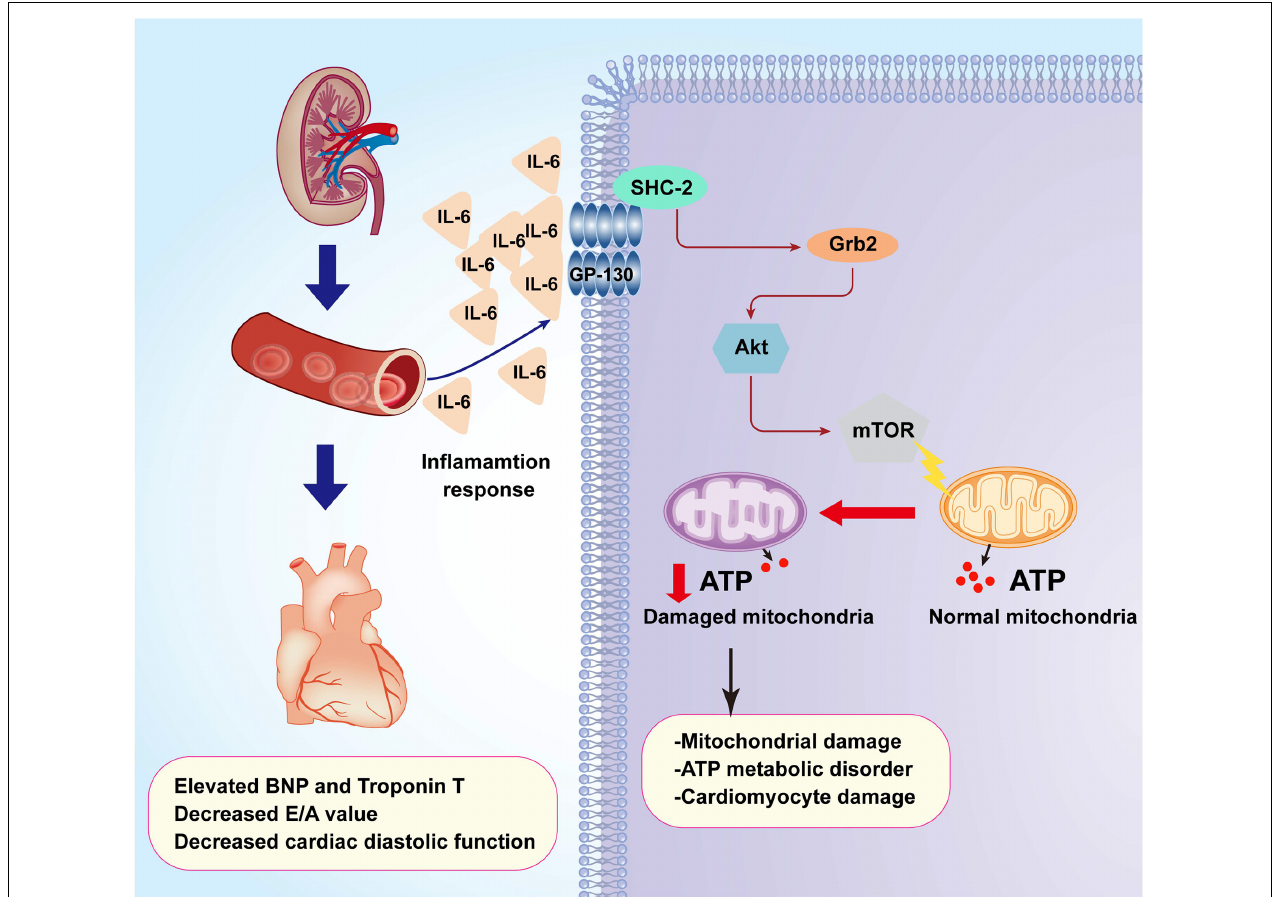
FIGURE 8 | A summary of the pathological alterations of CRS-3. Acute kidney injury (AKI) promotes inflammation response which elevates the concentrations of IL-6. Increased IL-6 upregulates the expression of Grb2 which mediates cardiomyocyte metabolism disorder through affecting the Akt/mTOR signaling pathway. Dysregulated cardiomyocyte ATP metabolism impairs myocardial relaxation and exacerbates cardiac injury after